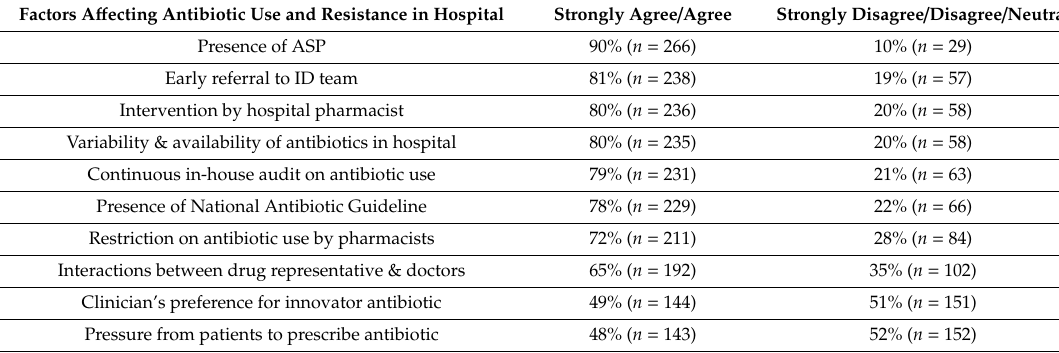
Table 5. Perceptions towards factors a ff ecting antibiotic use and resistance in the hospital. Factors A ff ecting Antibiotic Use and Resistance in Hospital